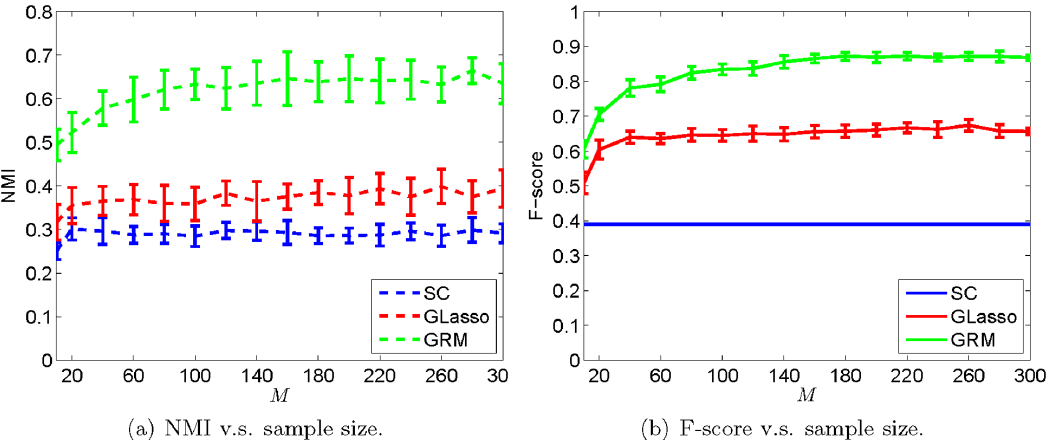
Fig 3. Performance of the graph structure learning methods v.s. the number of samples. In the left and right panels, we show the NMI and F-score between the estimated graph and the truth, respectively. The error bar indicates the standard deviation of the measurement. For every M , we ran the experiment 100 times by randomly generating the graph structure and the